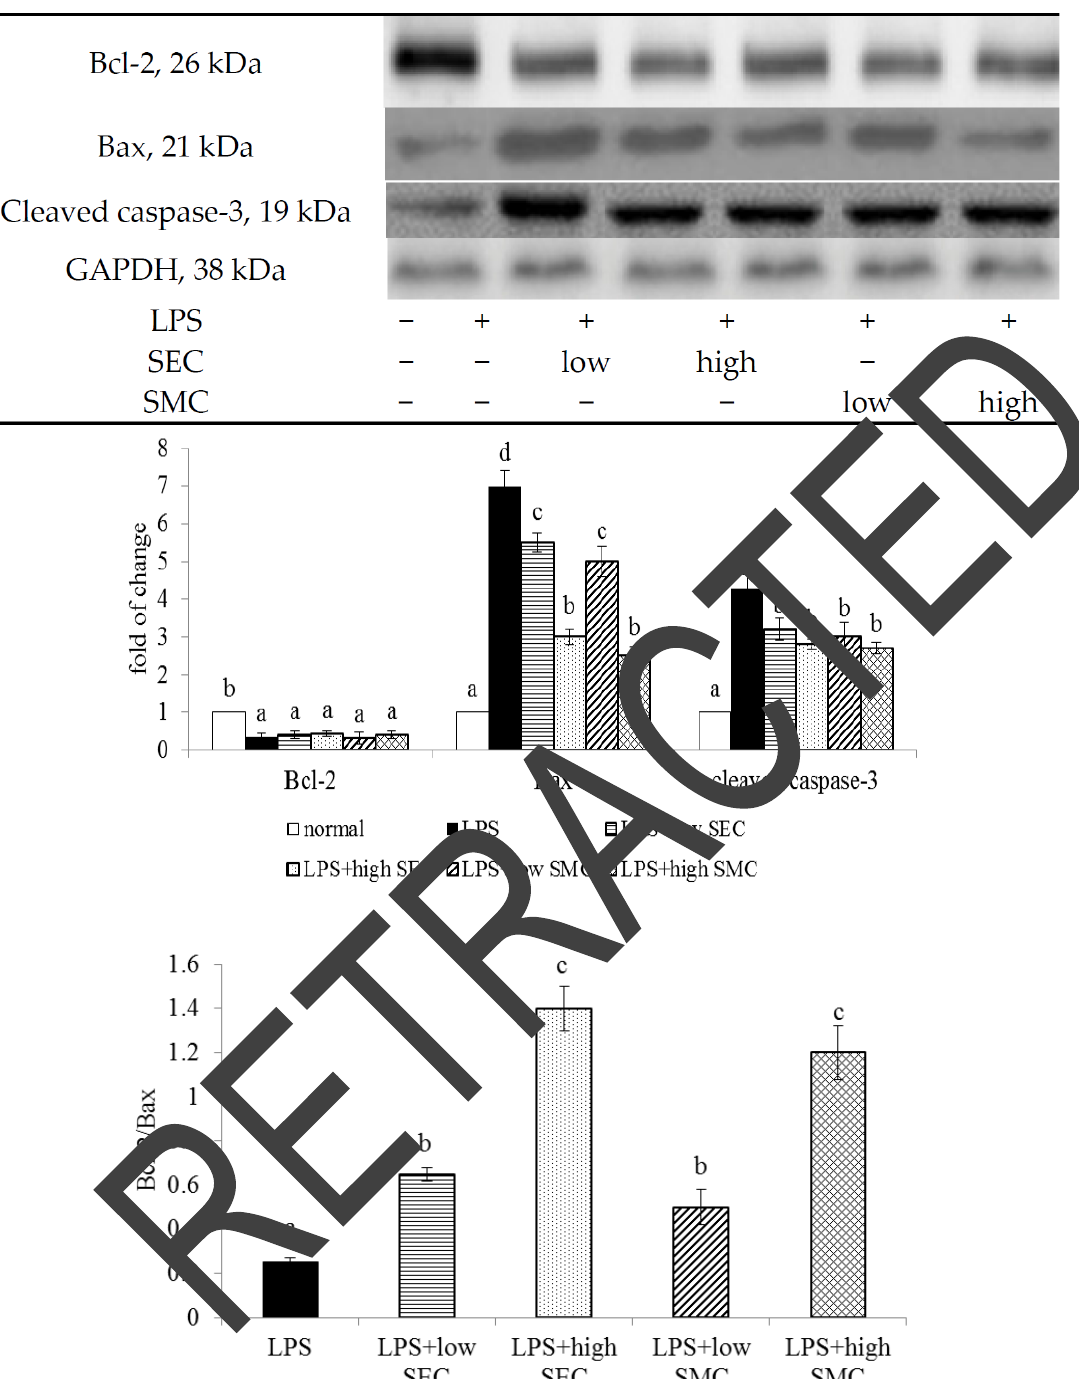
Figure 3. Lung expression of p47 phox , gp91 phox , GPX, GR and catalase of mice in normal group, LPS group, LPS + low SEC group, LPS + high SEC group, LPS + low SMC group and LPS + high SMC group after 3 ‐ day treatments. Data are mean ± SD, n = 10; a − e Means among bars without a common letter differ, p < 0.05.